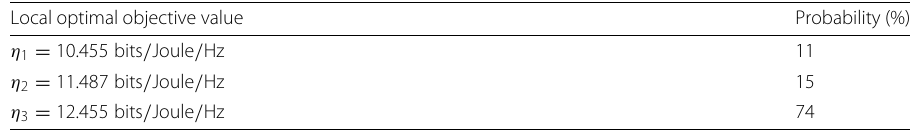
Table 2 Impact of random initial points on Algorithm